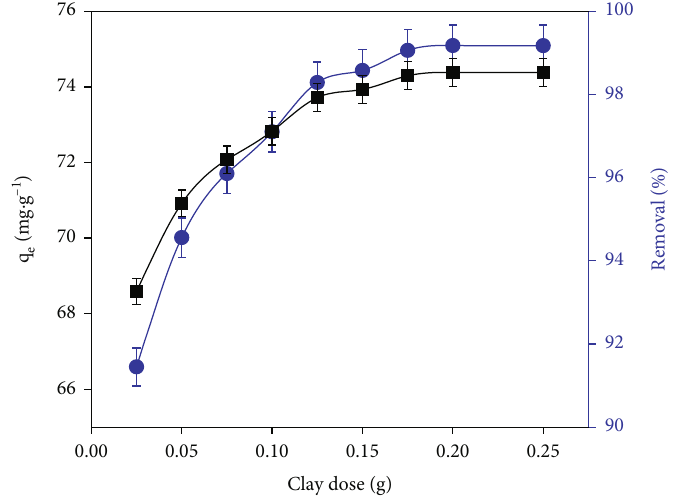
) of the TKC by the pH drift method. PZC